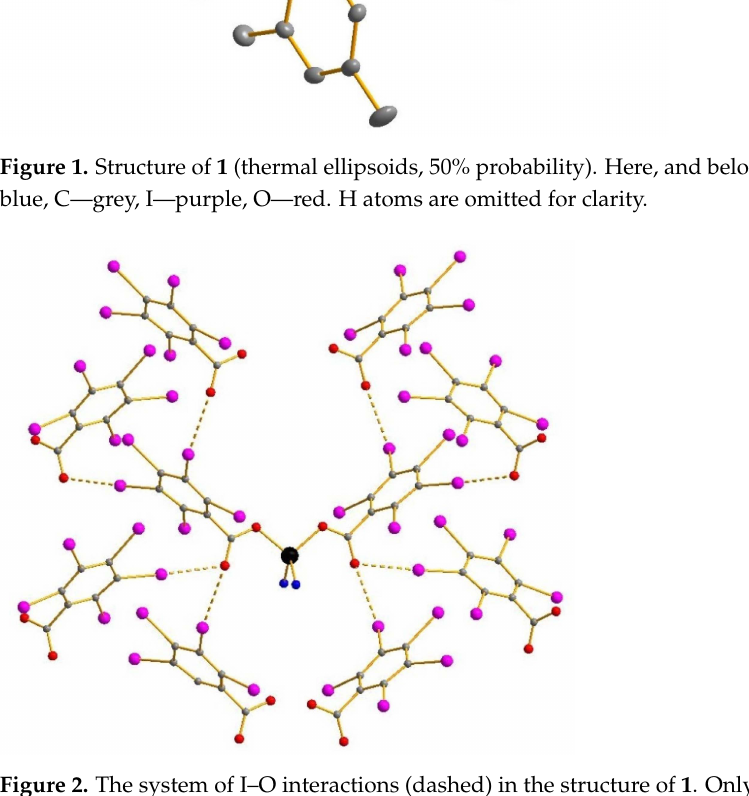
Figure 2. The system of I–O interactions (dashed) in the structure of 1 . Only N atoms of Py ligands are shown.